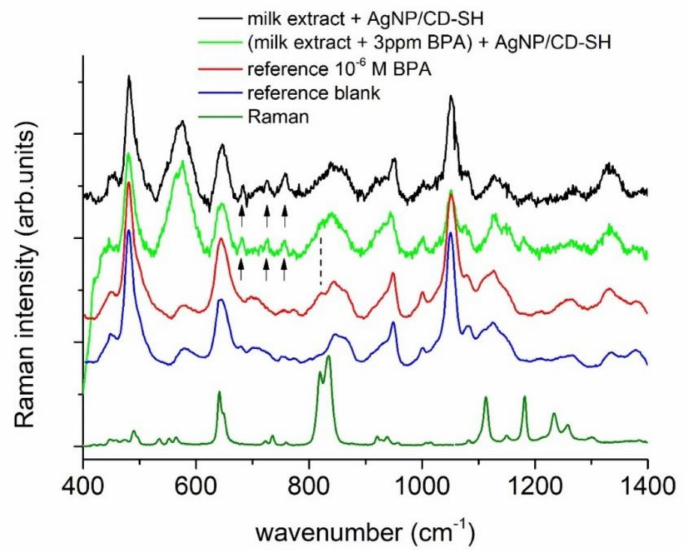
Figure 6. SERS spectra of both 1.0 × 10 − 6 M BPA samples and corresponding blanks from reference materials (bottom traces) and milk extracts (BPA spiked and blank). The dotted line indicates the BPA relevant band at 822 cm − 1 and the arrows indicate the spurious bands from